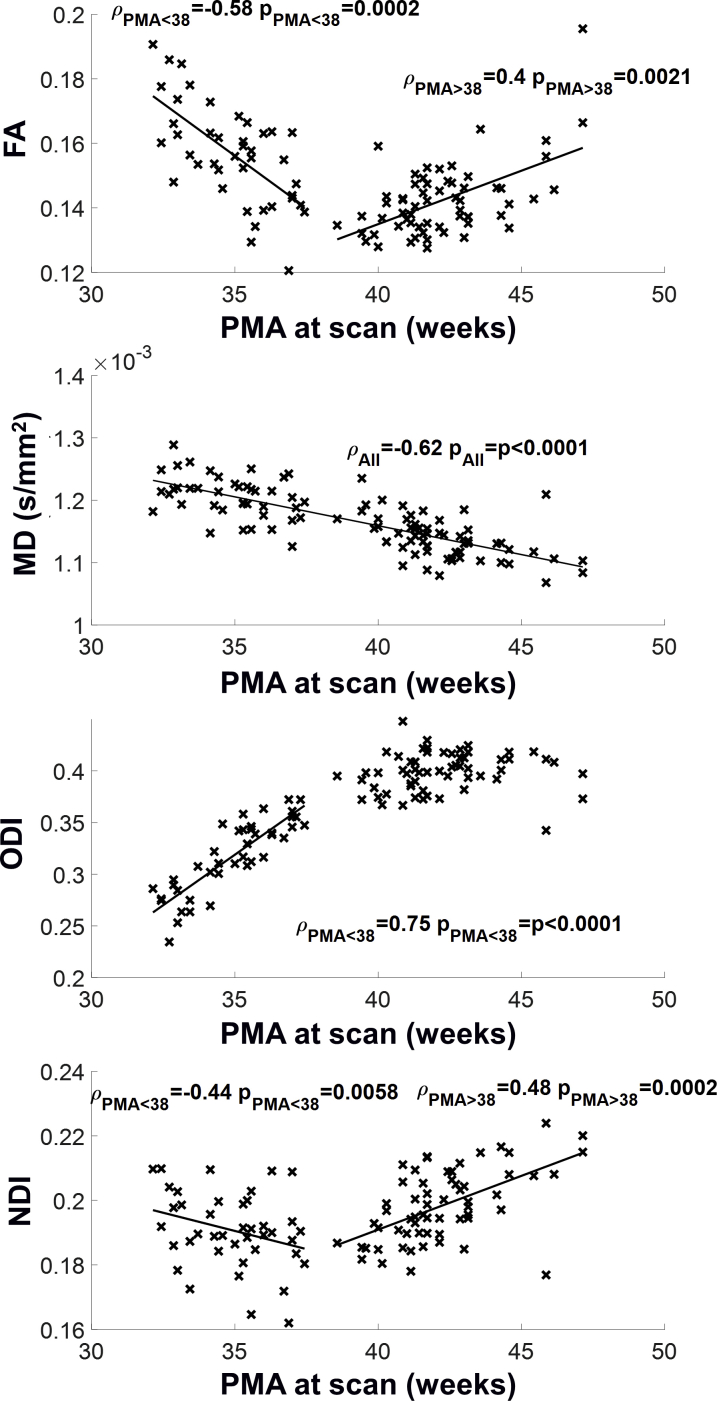
Whole-brain tissue analysis excluding subjects scanned <32 weeks PMA. Significant Spearman partial correlations <38, >38weeks and for the whole sample are highlighted with a regression line.